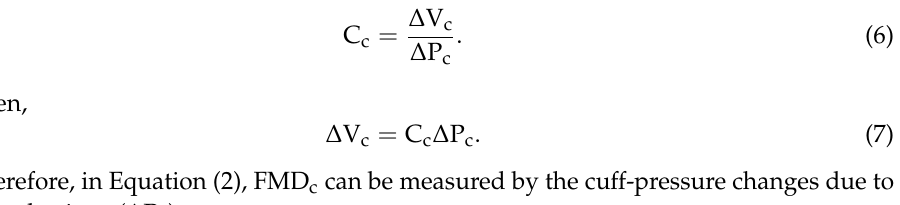
( b ) Figure 2. Interaction between the brachial artery and the cuff bladder: ( a ) relationship of the artery pressure to volume, ( b ) relationship of the cuff pressure to volume. Δ V a causes an effect on the cuff bladder, Δ V c . When Δ P c and Δ V c are very small, the compliance ( C c ) is defined as the ratio of Δ V c and Δ P c . The compliance of the cuff bladder C c ( P c ), depending on the P c , is defined as 𝐶 (cid:3030) (cid:4666)𝑃 (cid:3030) (cid:4667) = (cid:3031)(cid:3023) (cid:3278) (cid:3031)(cid:3017) (cid:3278) .